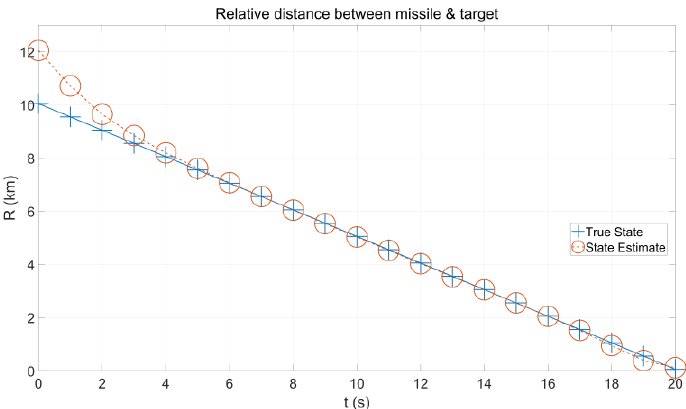
Figure 9. Trajectory of the relative distance and corresponding estimates.